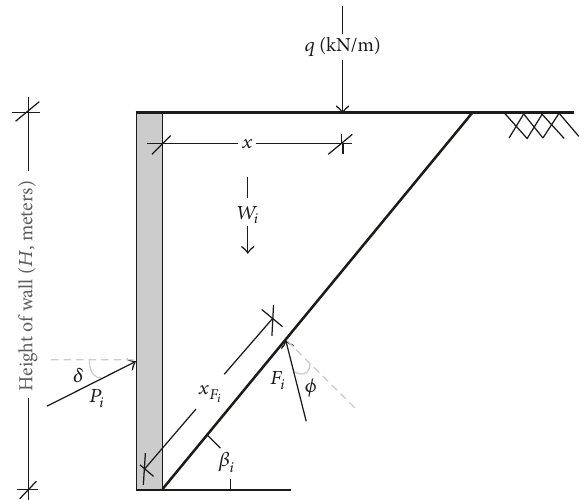
Figure 1: The equilibrium of forces in the 𝑖 th failure